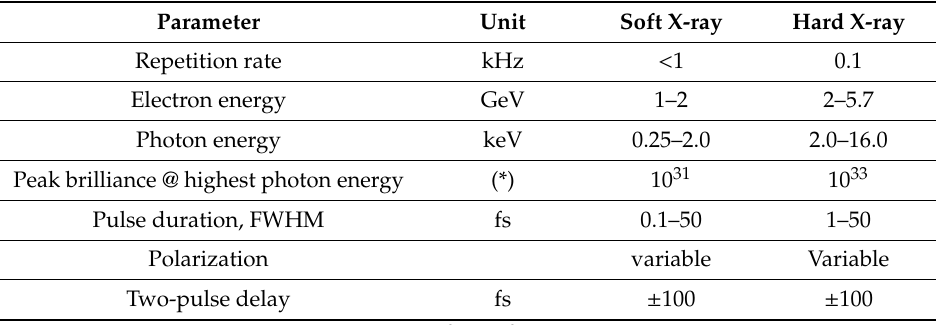
Table 1. CompactLight FEL parameters at the bunch charge of 75 pC.